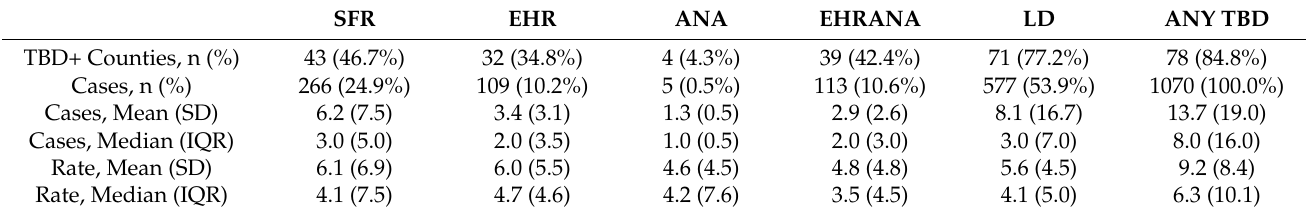
Table 2. Summary statistics of Human TBD frequency across 2017–2020 as reported by the IDOH. In addition to the number (%) of counties with at least one of each TBD case and the total number (%) of cases across counties, the table provides means and medians both for the raw total number of cases and the rate of incidence per 100,000 people. Only TBD+ counties were considered when calculating